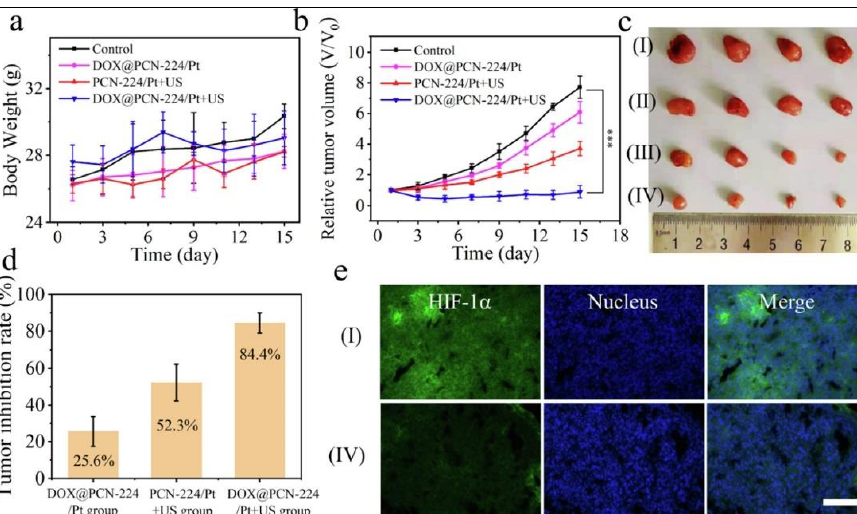
Figure 7. ( a ) Body weight and ( b ) relative tumor volume variation of mice from different study groups ( n = 4, *** p < 0.001 (highly significant); ( c ) photos of excised tumors on Day 15 post-treatment (I: Control; II: DOX@PCN-224/Pt; III: PCN-224/Pt + US; IV: DOX@PCN-224/Pt + US; US: Ultrasound) ; ( d ) tumor inhibition percentages of various groups ( n = 4); ( e ) effect of DOX@PCN-224/Pt nanopar- ticles on tumor hypoxia and HIF-1a expression: Immunofluorescence images of tumors following treatment with saline (control) or DOX@PCN-224/Pt + Ultrasound. (I: Control; IV: DOX@PCN-224/Pt + US; US: Ultrasound) (scale bar is 50 μ m). Reprinted with permission from Ref. [89]. Copyright 2022 Elsevier.